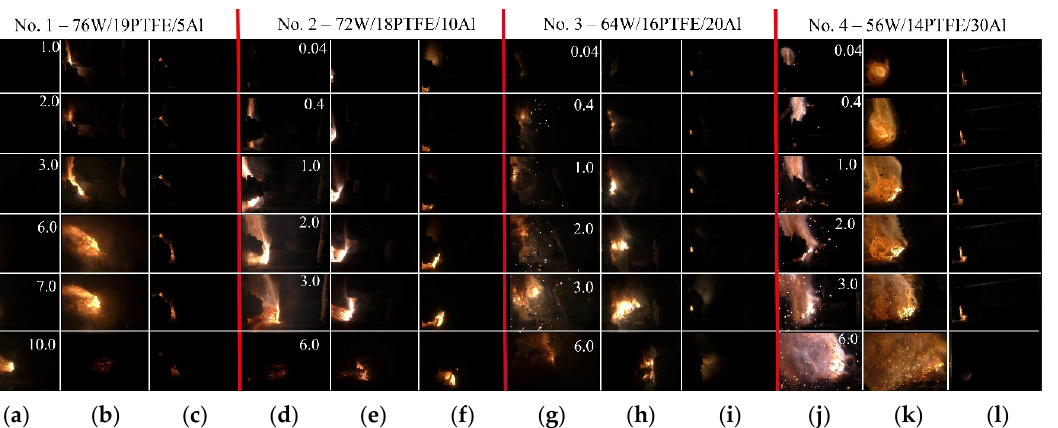
( a ) ( b ) ( c ) Figure 9. Specimens of composition No. 4 after combustion: ( a ) air; ( b ) argon; ( c ) vacuum. Table 3. Combustion rate in the W/PTFE/Al system. Composition